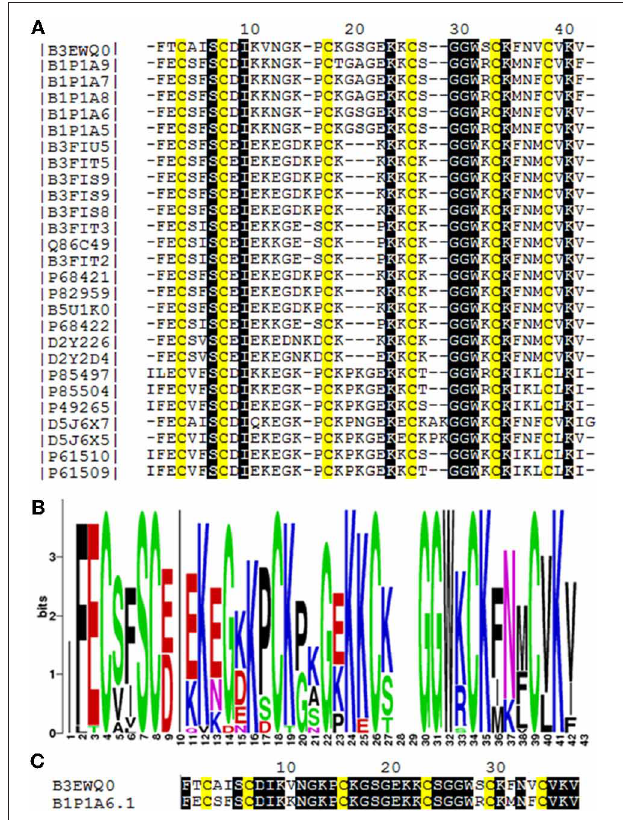
FIGURE 5 | Amino acid sequence comparision of Juruin (Aju1a) to other ICK-containing toxins. (A) Multiple sequence alignement of Juruin to selected toxins. Amino acid sequences of toxins were retrieved from public databases and aligned with Muscle (Egdar, 2004). Cysteines are in yellow. To minimize confusion, all sequences are referred to by their UniProt accession numbers ( http://www . uniprot . org/ ). Juruin (B3EWQ0), U3-theraphotoxin-Cj1a(B1P1A5), U3-theraphotoxin-Cj1a(B1P1A6), U3-theraphotoxin-Cj1b(B1P1A8), U3-theraphotoxin-Cj1b(B1P1A7), U3-theraphotoxin-Cj1c(B1P1A9) from Chilobrachys jingzhao . U1-theraphotoxin-Ba1b(P85504), U1-theraphotoxin-Ba1a(P85497) from Brachypelma ruhnaui . U1-theraphotoxin-Bs1a(P49265) from Brachypelma smithi . U1-theraphotoxin-Asp1b(P61510), U1-theraphotoxin-Asp1a(P61509) from Aphonopelmacalifornicum . Putative mature sequence toxin-like RFEC (D5J6X7), putative mature peptide toxin-like LFEC (D5J6X5) from Pelinobius muticus . U1-theraphotoxin-Lp1b(P61506) from Lasiodora parahybana . Hainantoxin-II-17 (D2Y2D4), Hainantoxin-II-15 (D2Y226) from Haplopelma hainanum . Huwentoxin-7 (P68421), U1-theraphotoxin-Hh1a(P82959), HWTX-VIII (B5U1K0), HWTX-II (B3FIU5), HWTX-VIIIa (B3FIT5), HWTX-IIb (B3FIS9), HWTX-IIa (B3FIS8), U1-theraphotoxin-Hh1f(P68422), Huwentoxin-2a(Q86C49), HWTX-VIIb (B3FIT3), HWTX-VIIa (B3FIT2) from Haplopelma schimidti . (B) Amino acid occurrence within selected toxins. (C) Structural similarity of Juruin to that of U3-theraphotoxin-Cj1a,from Chilobrachys jingzhao, to which Juruin shares 80% sequence similiarity. Conserved residues are shown in black